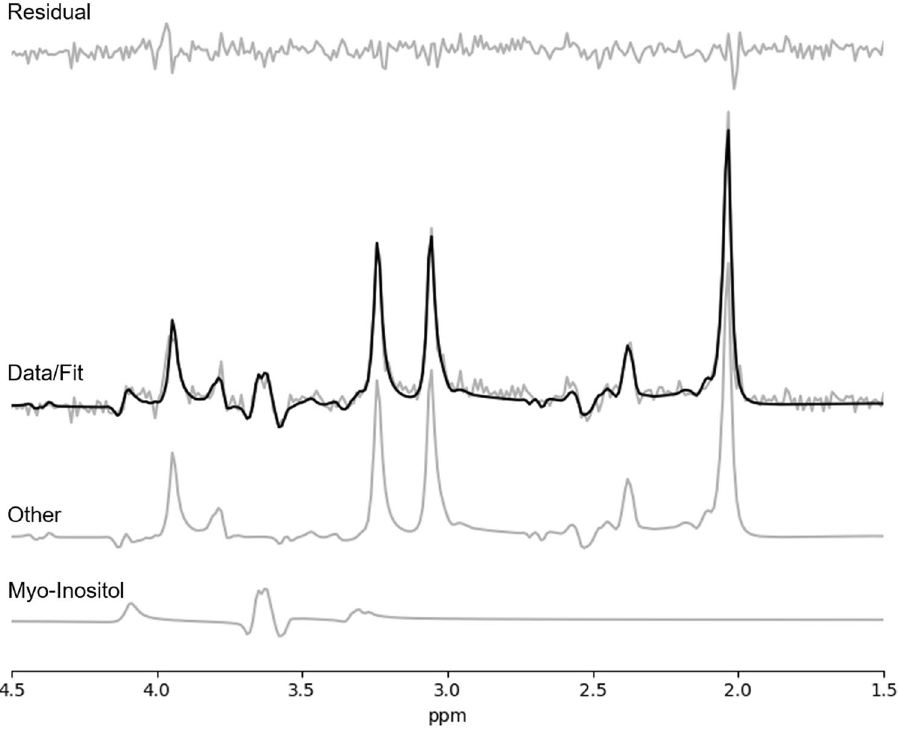
Figure 1. Sample fitted spectrum of a single participant. Fit spectrum (bolded) is overlaid on the raw spectrum with the residual spectrum displayed above. The myo-inositol spectra and the sum of the remaining 16 template-included metabolites (labeled as ‘other’) are displayed below.